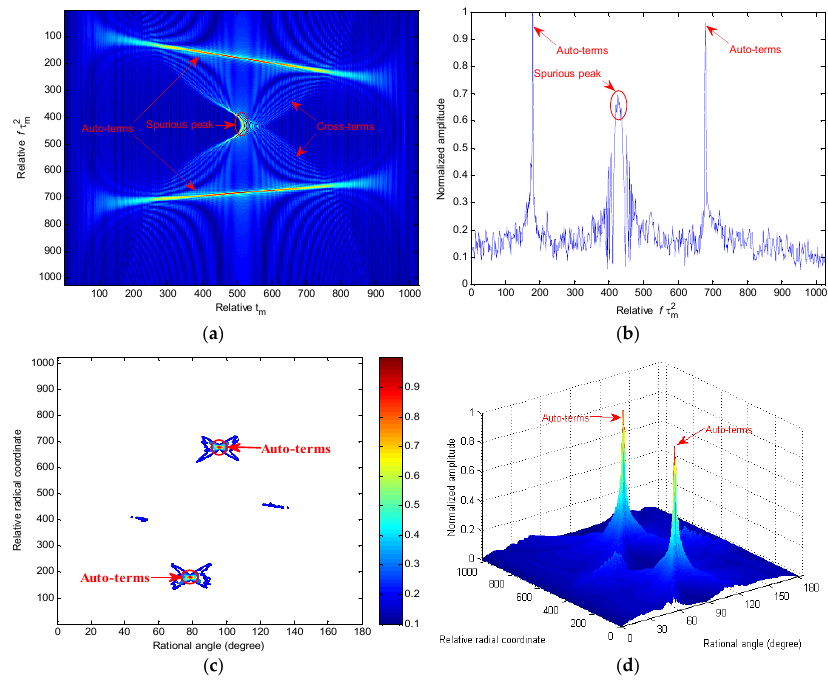
Figure 2. Simulation results of the multi-component QFM signal. ( a ) The results in the t m − f τ 2 plane after CPF operation; ( b ) the slice obtained by the CPF at t m = 512; ( c ) Contour image of QFM signal obtained by the proposed RCFT method; ( d ) mesh image of QFM signal obtained by the proposed RCFT method.